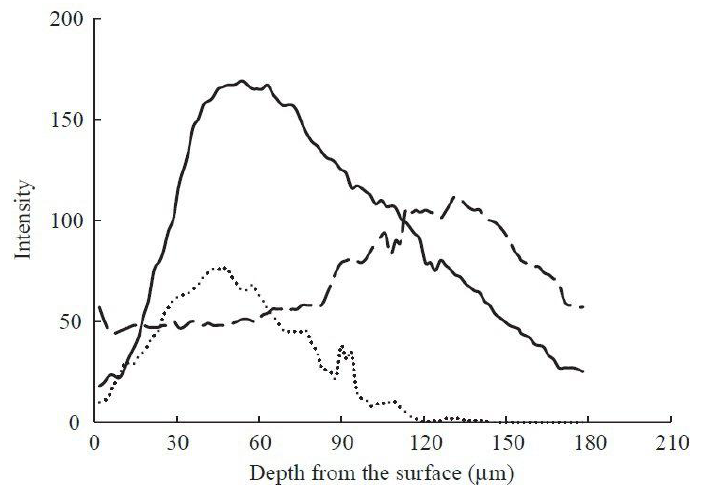
Figure 3. Fluorescent intensity of pectin formulations extending from the surface of the lumen to deep within the wall made through the stacks of optical sections. P-N (solid line), P-25 (broken line) and P-94 (dotted line)